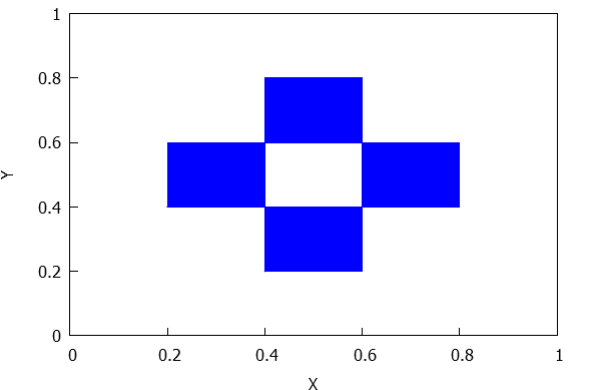
Figure 10. A and B mixing. Distribution D4. | L | = 4. A contains 1 interval and f 1 ( A ) ∩ Int ( B ) = ∅ but f 1 ( A ) ∩ B (cid:54) = ∅ ; in this case, the intersection are two points; B has 2 intervals; | L 1 | = | L 2 | = 2. Rectangles from L 1 have two vertices in common with rectangles from L 2 and the same for rectangles from L 2 .